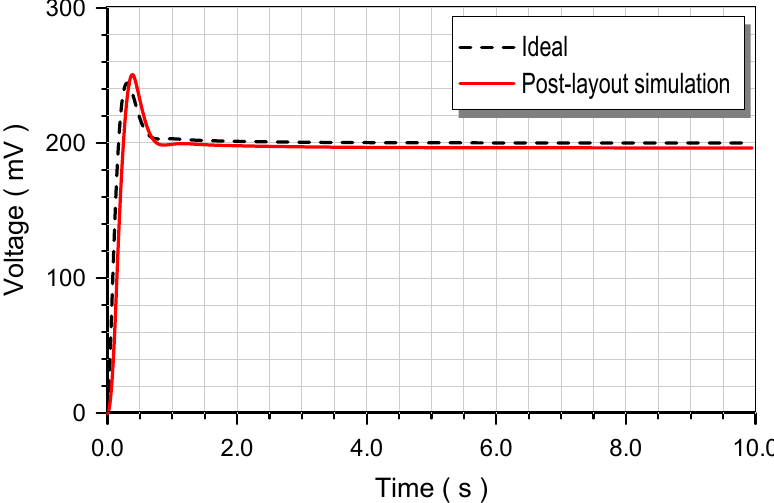
Figure 8. Post-layout step response of the closed-loop system stimulated by an input voltage of 200